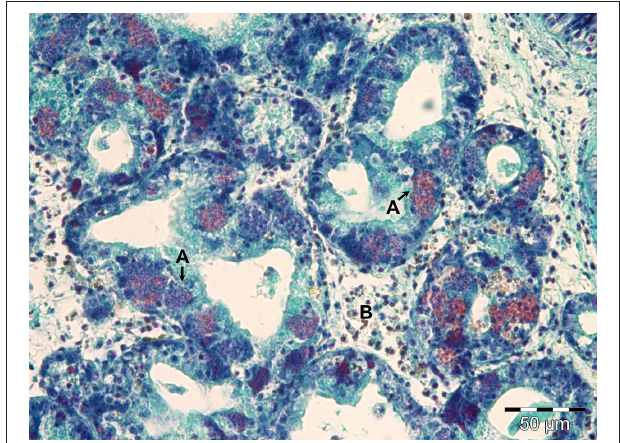
FIGURE 2 | Digestive gland of P. nobilis . Mature ellipsoidal uninucleate spores were found in the epithelia of digestive tubules (A) . A heavy inflammatory host response, with infiltration of the connective tissue by hyaline hemocytes, was associated with infection (B) . Note that the epithelium height of the digestive tubules was reduced, resulting in a wider